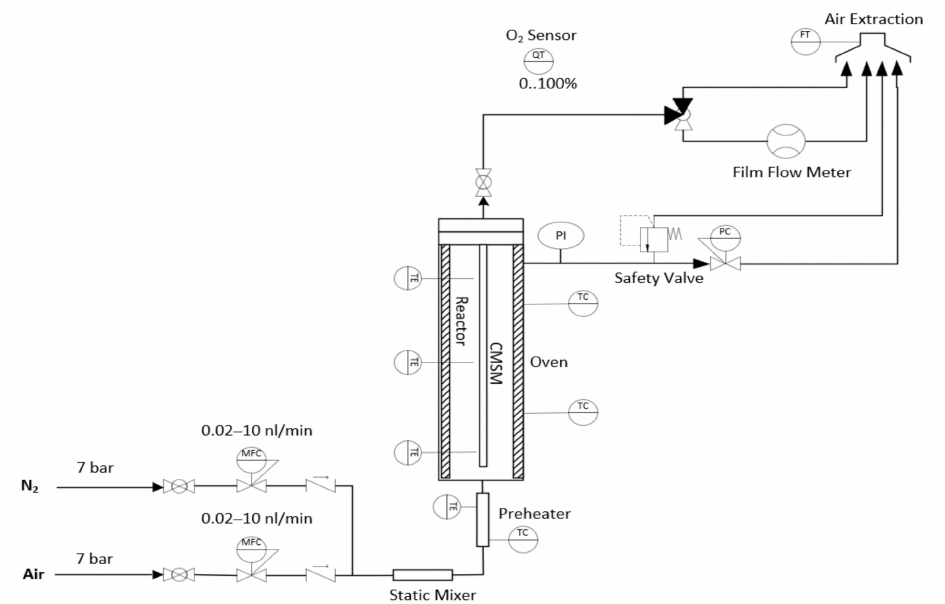
Figure 3. The membrane reactor for post treatment of CMSMs (Carbon Molecular Sieve Membranes) in an oxidative atmosphere. MFC (Mass Flow Controller), PC (Pressure Controller), FT (Flow Transmitter), TC (Thermocouple), PI (Pressure Indicator), TE (Temperature